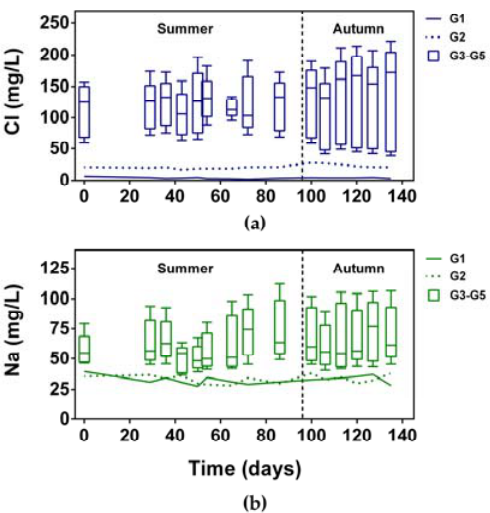
Figure 6. Concentration of Cl and Na in groundwater sampling wells (G1, road control; G2, residential control; and G3 to G5, study wells) for the monitoring performed from summer to autumn 2013: ( a ) Cl and ( b ) Na. Solid and dottedlines represent mean values for G1 and G2, respectively. Boxplots show the lower, median, and upper quartiles for G3–G5, with whiskers extending to the most extreme data point.